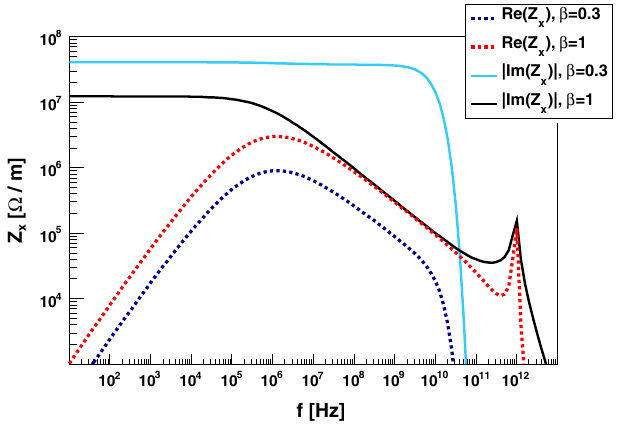
FIG. 4. (Color) Transverse wall impedance for the case of an LHC collimator with b ¼ 2 mm assuming infinitely thick graph- ite jaws with (cid:9) ¼ 0 : 3 (dashed blue and solid cyan lines) and (cid:9) ¼ 1 (dashed red and solid black lines). The other parameters are those of Fig.